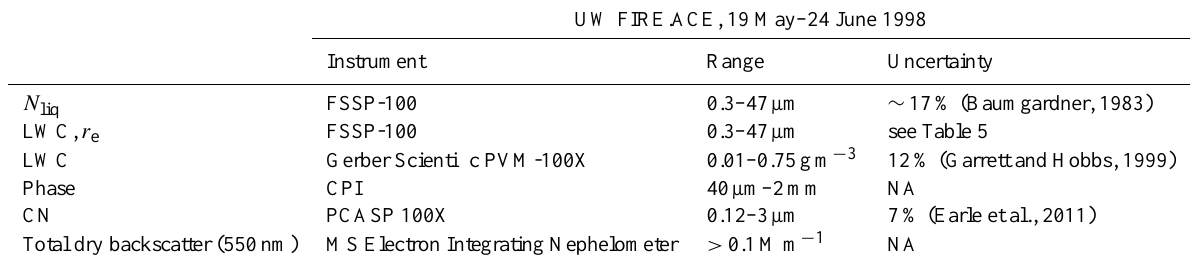
Table 4. Instrumentation used in this study from the UW FIRE.ACE data set. Data were collected at 1s